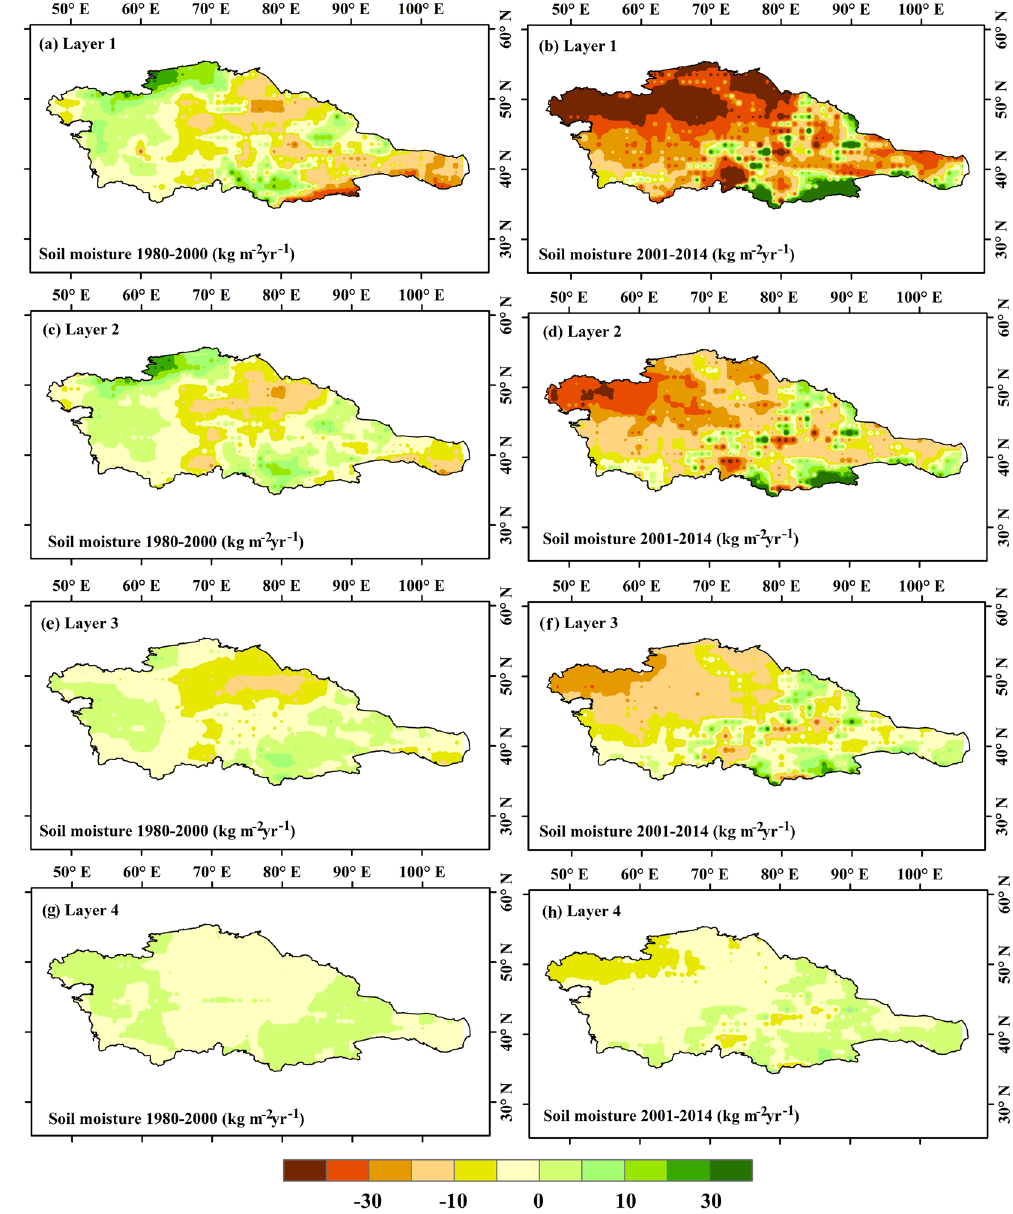
Figure 4. Average soil moisture in four layers during 1980–2014. (Generated by ArcGIS 10.2, URL: http://www. decreased significantly in Central Asia, particularly in northwestern Kazakhstan and some parts of Kyrgyzstan and Tajikistan (Fig. 5). In the arid region of northwest China (e.g., northern slope of the Tienshan Mountains, southern margin of the Tarim Basin, and the Hexi Corridor), NPP experienced an increasing trend. The same regions also had increased soil moisture. Rising ET exacerbates regional ecological droughts in the past decade. ET a a was a crucial variable that amplified the soil moisture loss 36 and had contributions from three main components: direct evaporation from the soil (E s ), transpiration from vegetation (E c ), and vaporization of intercepted rainfall from vegetation (E i ). The relative contributions from E s and E i were larger in Central Asia. E s was mostly driven by the atmospheric demand for vapour, the availability of water in the soil, and the amount of vegetation above the soil, while E c was dependent on plant phenology and water-use efficiency, and E i by the occurrence of rainfall and the characteris- tics of the vegetation stand 37 . In areas characterized by less moisture, increases in precipitation were insufficient to offset increases in evap- orative demand as land-surface temperatures rose 38 . The multi-decadal declining trend (1981–2012) in ET a con- tinued until about 2000, and then gradually turned slightly positive. The average inter-annual variance of ET a